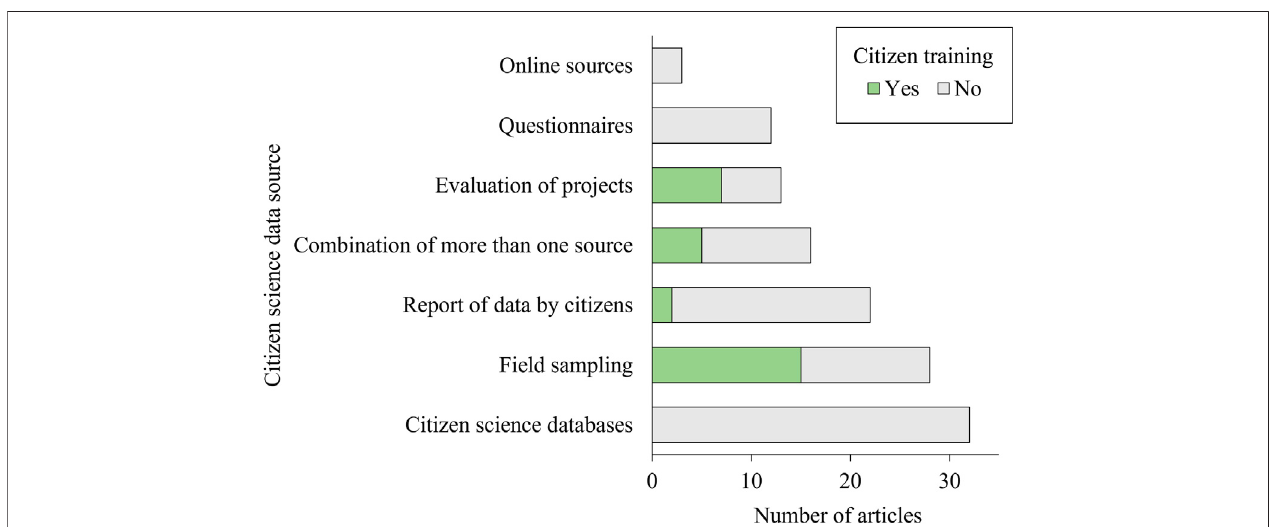
FIGURE 4 | Number of articles published on citizen science and non-indigenous species according to the data source used in the study (seven categories) and if citizen scientists received training under the scope of the study. Atotal of 122 studies reported information on this issue. Data were retrieved from a bibliographicsurvey made in July 2019 with SCOPUS using a combination of keywords: “ invasive species ” and “ citizen science ” , “ non-indigenous species ” and “ citizen science ” , and “ non- native species ” and “ citizen science ” .